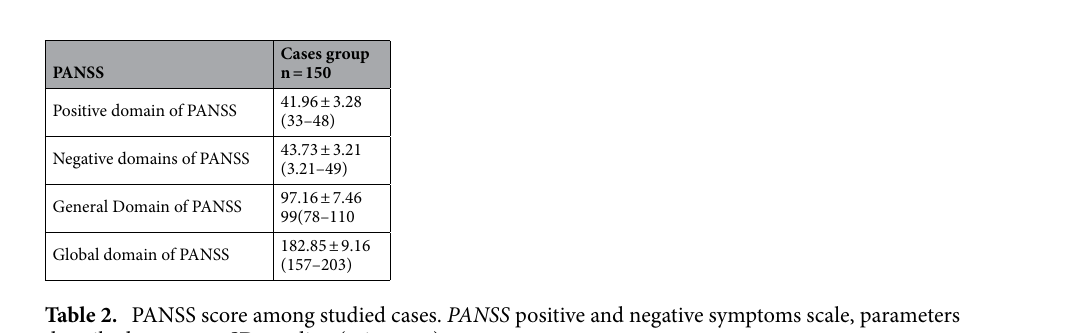
Table 2. PANSS score among studied cases. PANSS positive and negative symptoms scale, parameters described as mean ± SD, median (min–max).